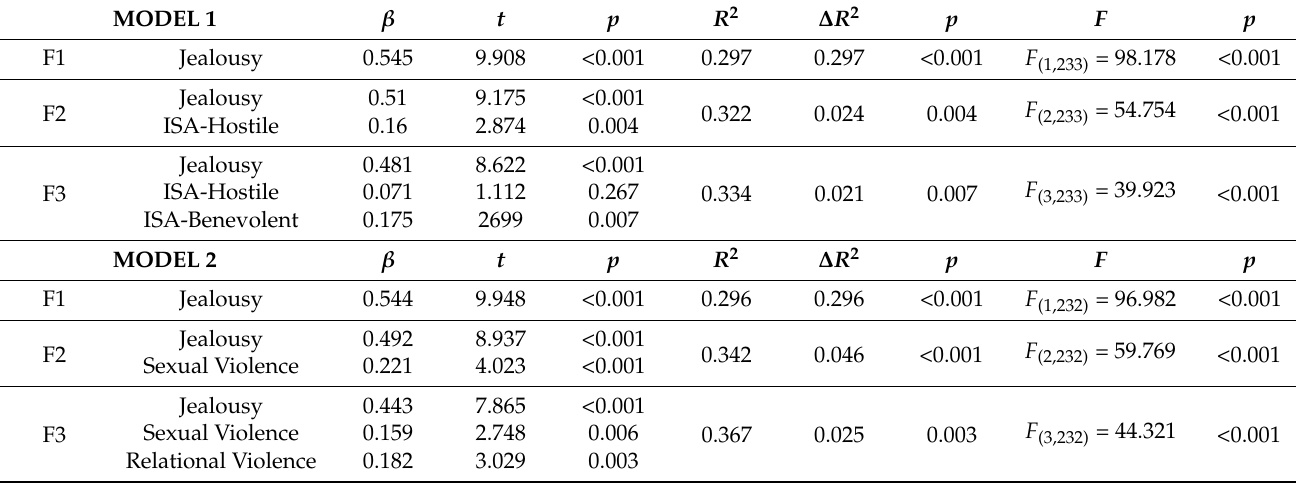
Table 6. Linear stepwise regression of predictor variables (Love Addiction Scale jealousy subscale, ASI subscales and CADRI subscales) on Partner’s Emotional